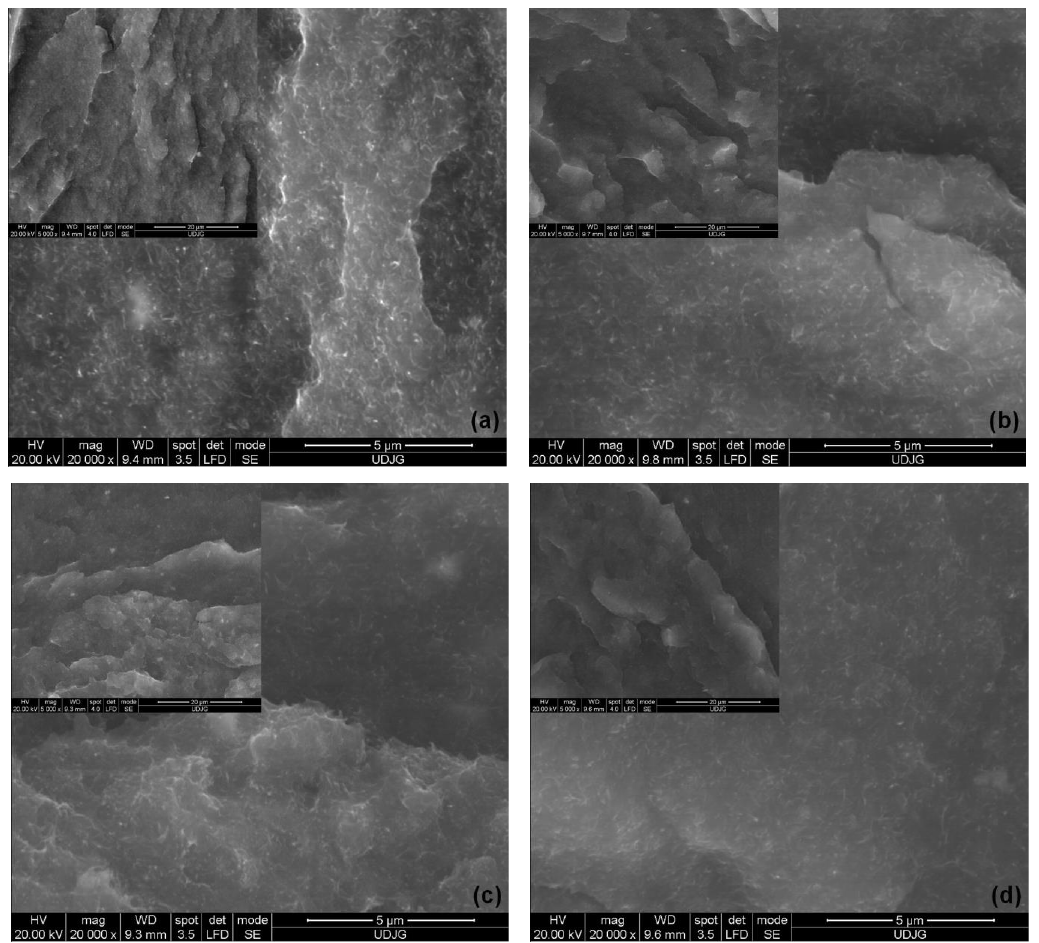
Figure 11. SEM micrographs of cryogenic surface fracture at 20,000× magnification (insets at 5000×) for the ( a ) R 0 , ( b ) R 1 , ( c ) R 2 and ( d ) R 3 composites with 5 wt.% of MWCNTs.